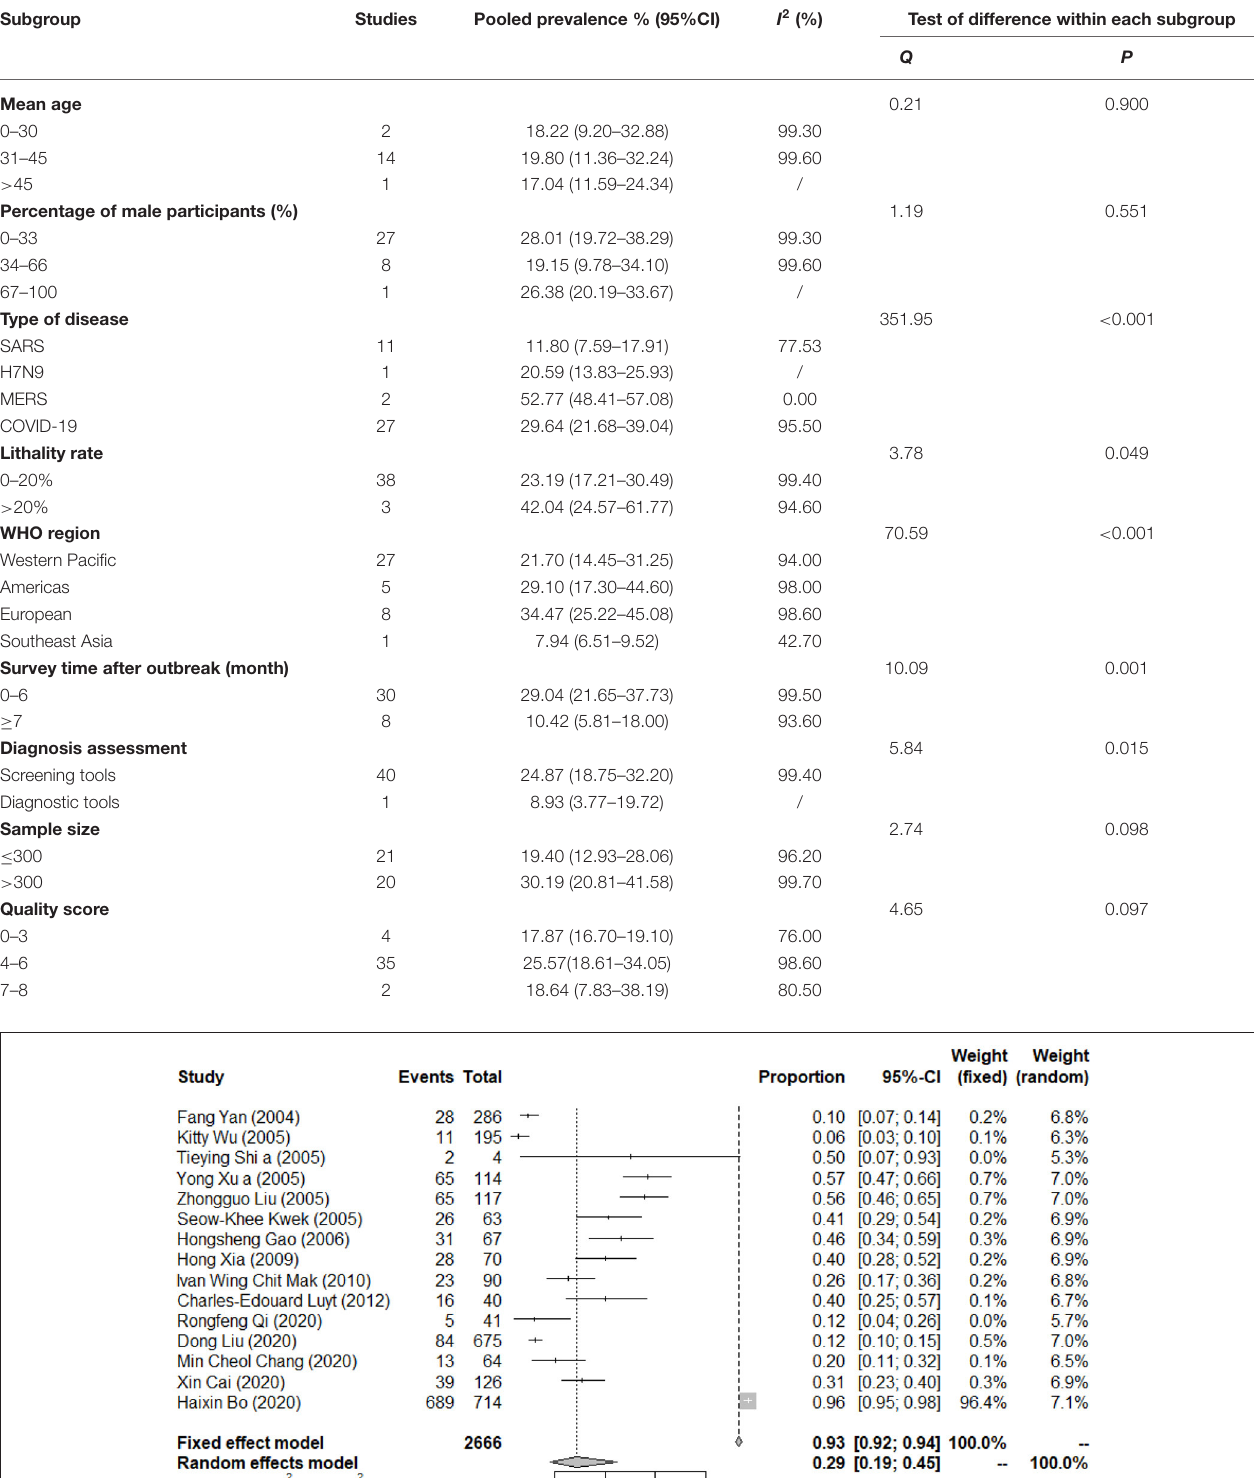
TABLE 3 | Subgroup analysis for healthcare workers.